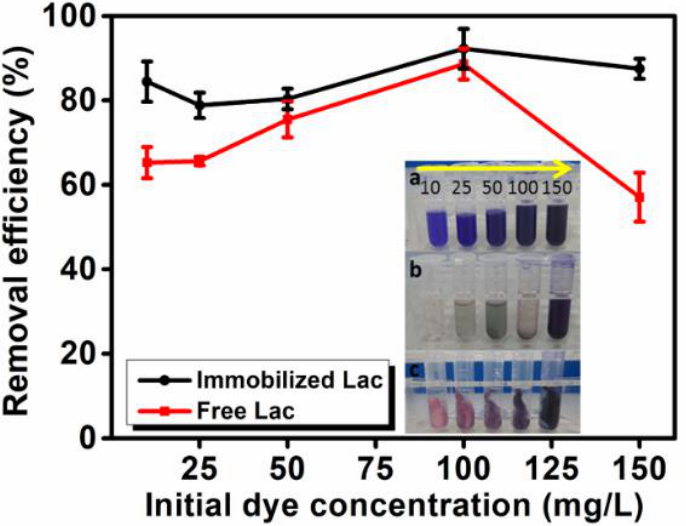
Figure 7. Effect of initial dye concentration on CV removal efficiency. Digital photograph of ( a ) initial Figure 7. E ff ect of initial dye concentration on CV removal e ffi ciency. Digital photograph of ( a ) initial CV (from left to right are 10, 25, 50, 100, 150 mg/L, respectively); the corresponding CV solutions after CV (from left to right are 10, 25, 50, 100, 150 mg / L, respectively); the corresponding CV solutions after removal by ( b ) free Lac and ( c ) immobilized Lac at 40 °C for 5 h. removal by ( b ) free Lac and ( c ) immobilized Lac at 40 ◦ C for 5